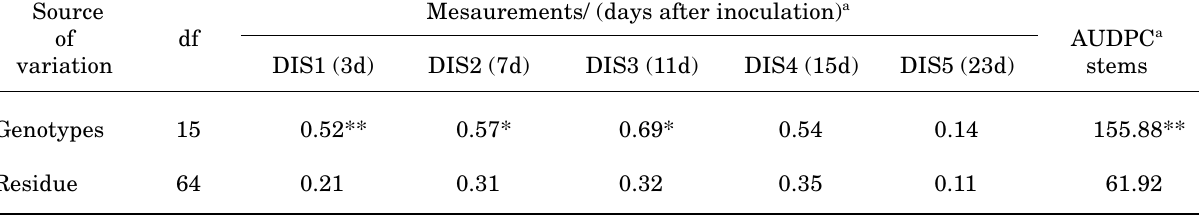
Table 4. ANOVA of stem infection 3 to 23 days after inoculation (DIS1–IS5) and of area under disease progress curves (AUDPC) (for stem infection) under greenhouse conditions. Source Mesaurements/ (days after inoculation) a of df AUDPC a